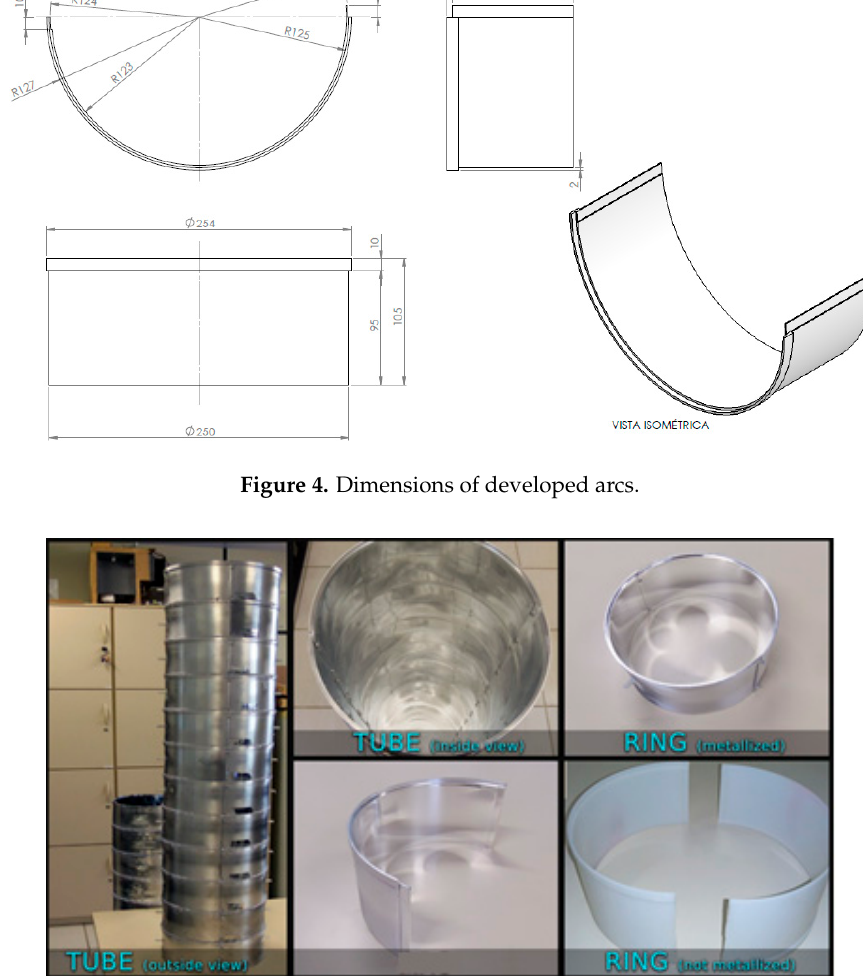
Figure 5. Reflective tube assembly (bows and rings).